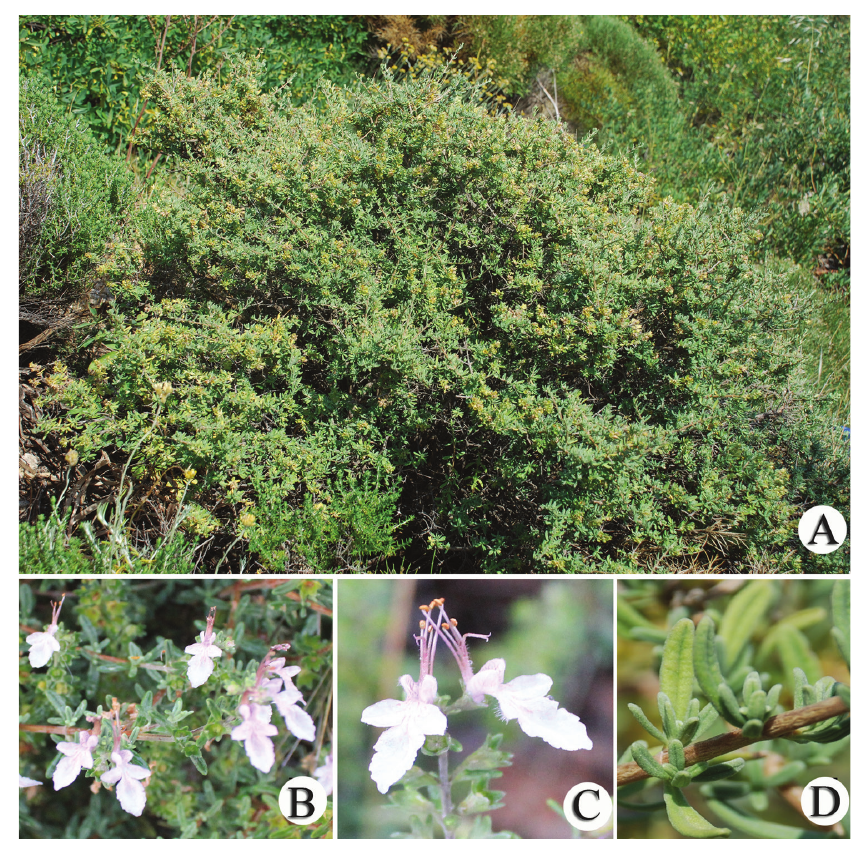
Figure 3. T. brevifolium. A habitus B inflorescence C flower D